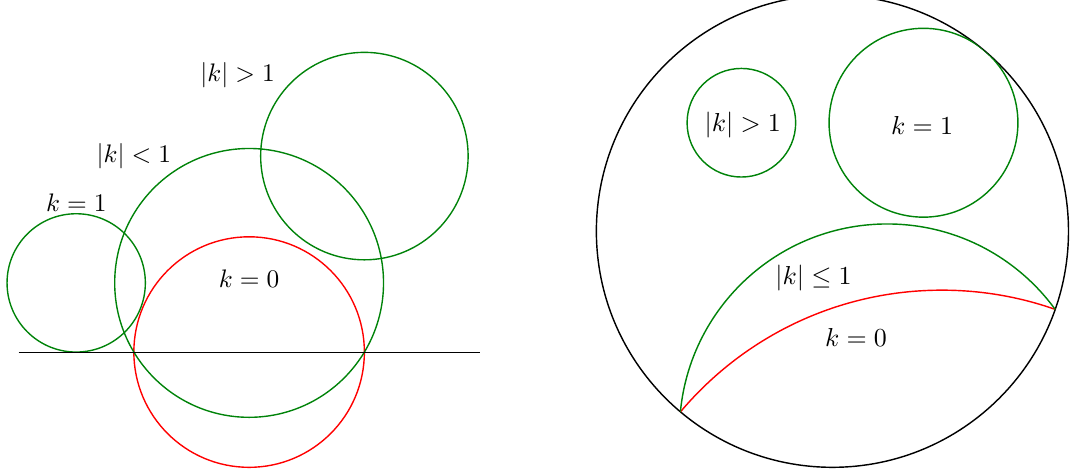
Figure 2 . Figure showing the different curves of constant k in the Poincaré plane and disk. The sign of k is dependent on the direction of the normal vector perpendicular to the boundary; for instance, for | k | > 1 , k > 1 is the boundary of the compact space (the disk), and k < − 1 is the boundary of the non-compact space (the outside of the disk). In this paper, we will focus on k > 0 to simplify our higher genus